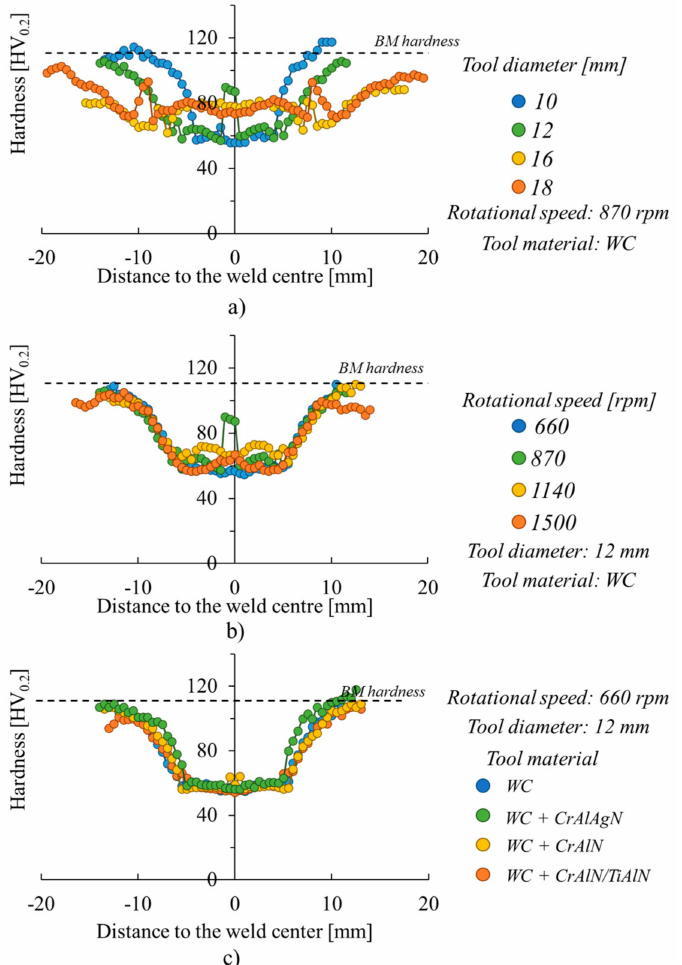
Figure 8. Hardness profiles for the welds produced with the AA6082 aluminium alloy with ( a ) the uncoated tool, at constant rotational speed of 870 rpm and varied tool diameters between 10 to 18 mm, ( b ) with the uncoated tool, at constant tool diameter of 12 mm, and varied rotational speed between 660 to 1500 rpm and ( c ) with the WC uncoated tool and the WC tools coated with the CrAlN, CrAlAgN and CrAlN/TiAlN films, and a constant tool diameter and rotational speed of 12 mm and 660 rpm,